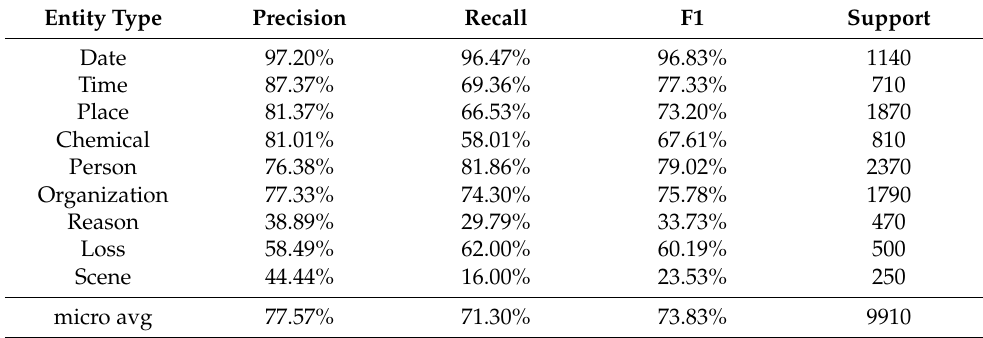
Table 4. Recognition results for 9 types of entities.